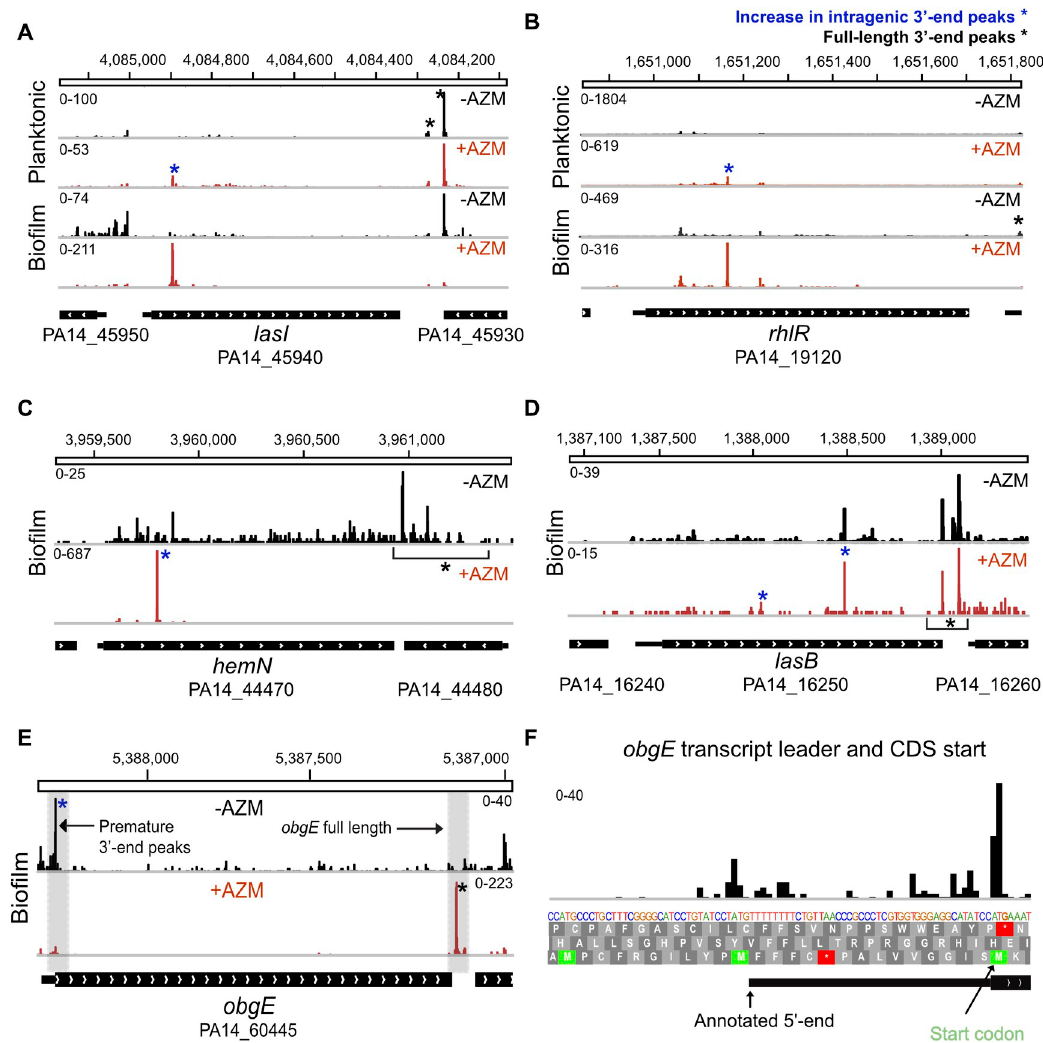
Fig 3. AZM alters intragenic 3’ end peak formation in PA14 genes. (A and B) AZM dependent increase in intragenic premature 3’ end peaks in lasI and rhlR genes. IGV views of lasI and rhlR in control (-AZM) and AZM treated (+AZM) treated samples from planktonic and biofilm cultures are shown. Intragenic peaks whose relative levels are altered by AZM are indicated with blue asterisks. The lasI gene in planktonic cultures and biofilm showed ~16 fold and ~41 fold increase in I/FL peak ratio upon AZM treatment, respectively. AZM treatment resulted in an ~8 fold increase in I/FL peaks for rhlR in biofilms. The peak is not prominent in planktonic cultures. (C) IGV view of the hemN gene downregulated by AZM (DEseq2 log 2 fold change = -1.2) shows a 60 fold increase in I/FL peak ratio. The effect is less pronounced in planktonic cells (D) IGV view of lasB downregulated by AZM (DEseq2 change = ~1.95) shows moderate increase in I/FL ratio (1.74 fold) in the presence of AZM. (E) 23 fold upregulation of obgE is accompanied by a 42 fold reduction in transcription attenuation in its transcript leader. (F) A closer view of the transcript leader and CDS start shows termination before the rare codon for Lys at the obgE start